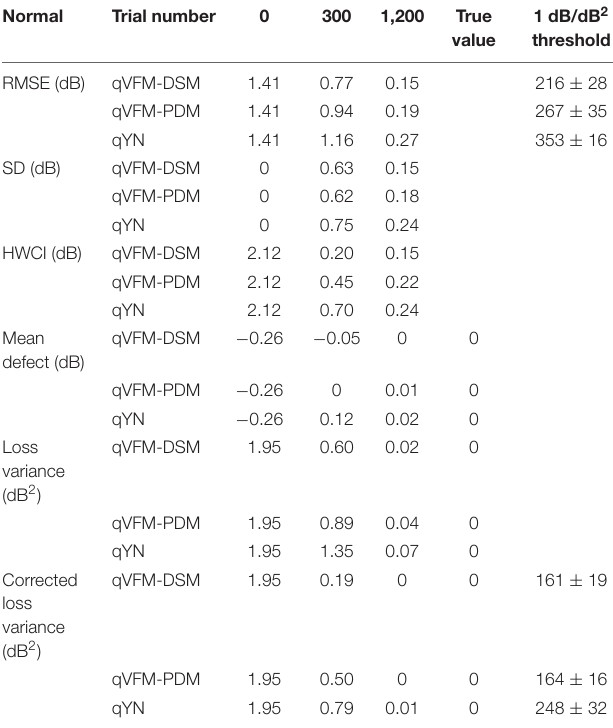
The corresponding true values are listed in the sixth column. Trial numbers needed to achieve 1 dB RMSE and 1 dB 2 within the corrected loss variance are listed with their SD in the last column.